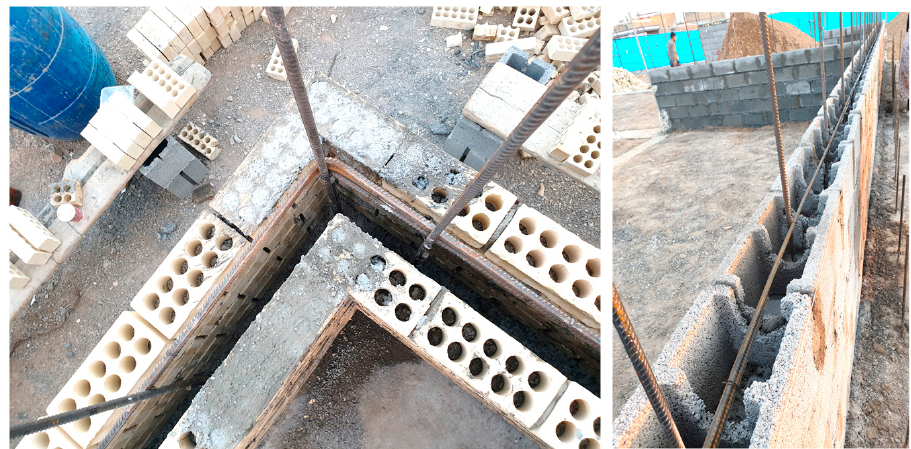
Figure 9. RM walls reinforced with steel bars, Shiraz, Iran.